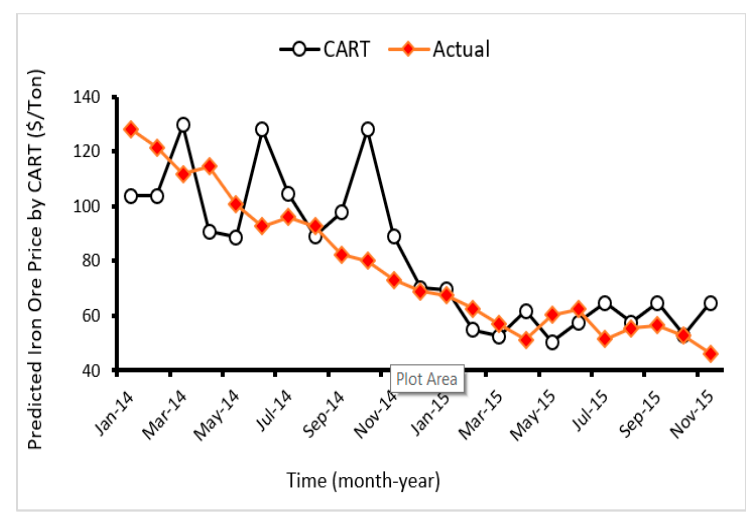
Figure 11. Comparison between the measured and the predicted by CART model for test stage.